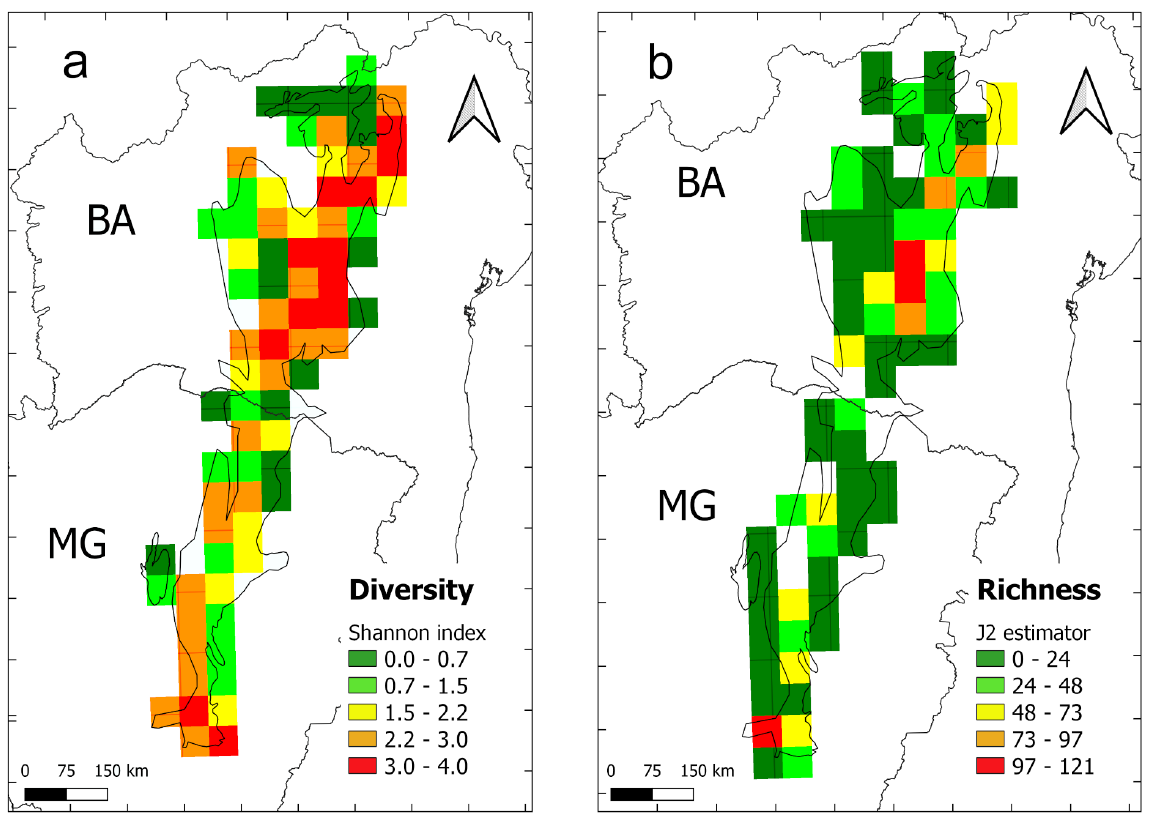
Figure 4. Maps of diversity and richness of Convolvulaceae in the Espinhaço Range. (a) Species diversity is concentrated mainly in the Bahia portion (Chapada Diamantina) and secondarily in the extreme south of the ER (Iron Quadrangle). (b) Jackknife2 estimator pointed out that species richness is also mostly concentrated in the Chapada